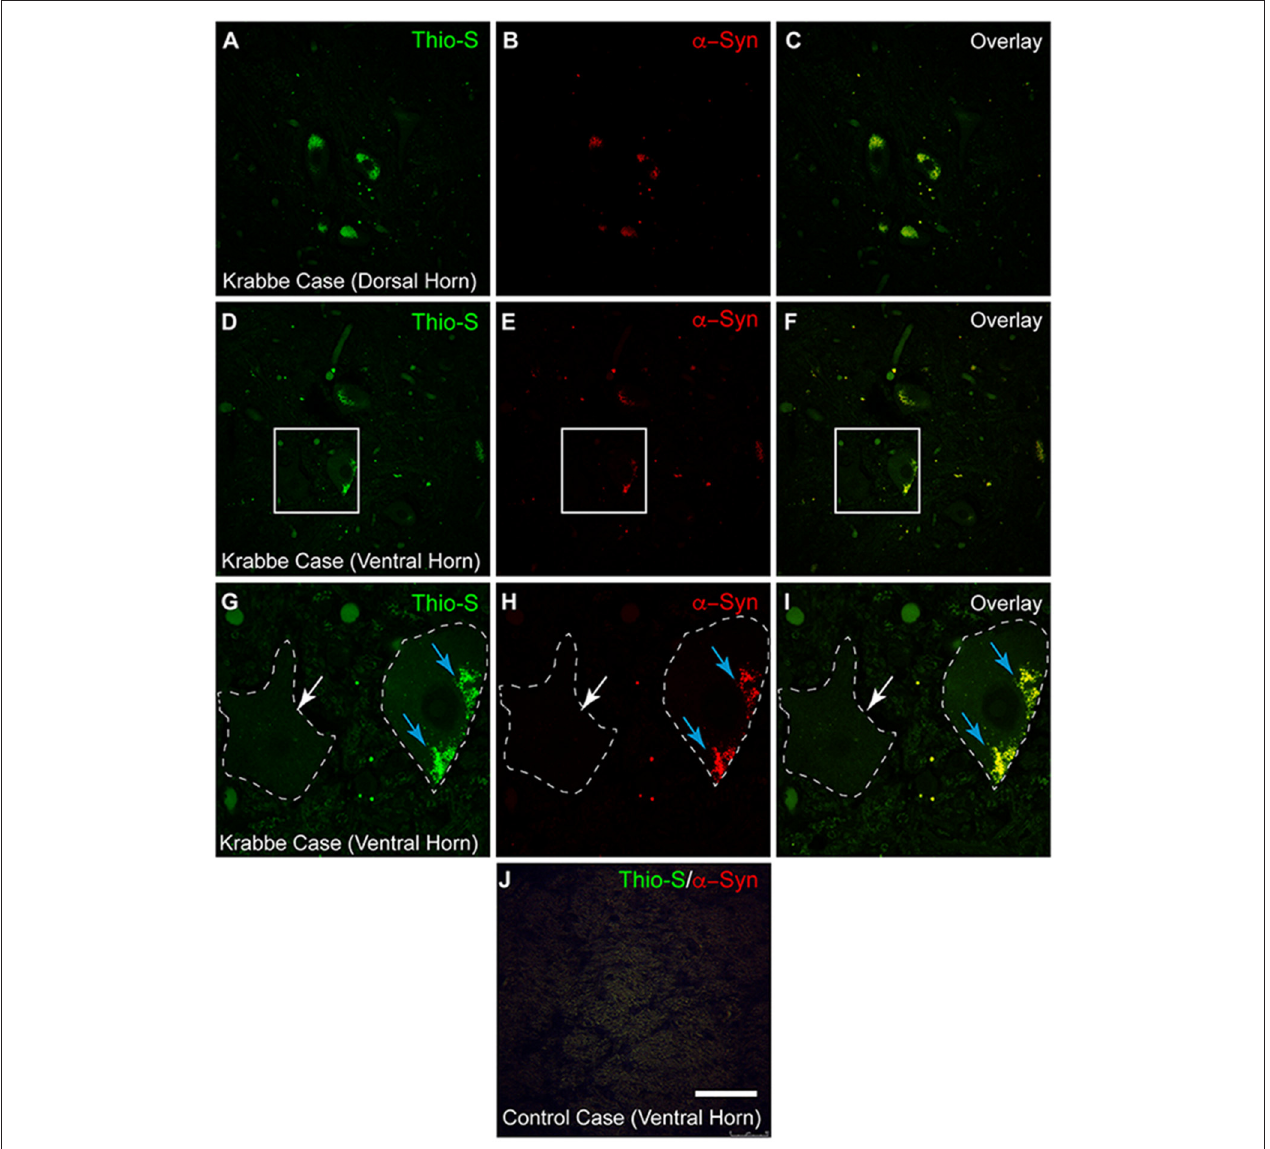
FIGURE 5 | Alpha-synuclein staining in human Krabbe disease patients. Human spinal tissue from a patient with Krabbe (A–F) was stained with thioflavin-S (A,D) and for α -synuclein ( α -syn) (B,E) . Overlay of the two channels demonstrated colocalization of thioflavin-S reactive material with α -syn in cells of both the dorsal horn (C) and ventral horn (F) . (G–I) [corresponding to the boxes in (D–F) , respectively] show a cell with thioflavin-S and α -syn positive material as highlighted by the blue arrows compared to an unaffected cell highlighted by the white arrow. Cell comparison between panels is highlighted by white dashed line. Affected patients were both 2 years of age and in terminal stage of disease. Last, spinal tissue stained concurrently from an unaffected control case is shown in (J) . Scale bar represents (A–F) : 40 µ m; (G–J) : 20 µ